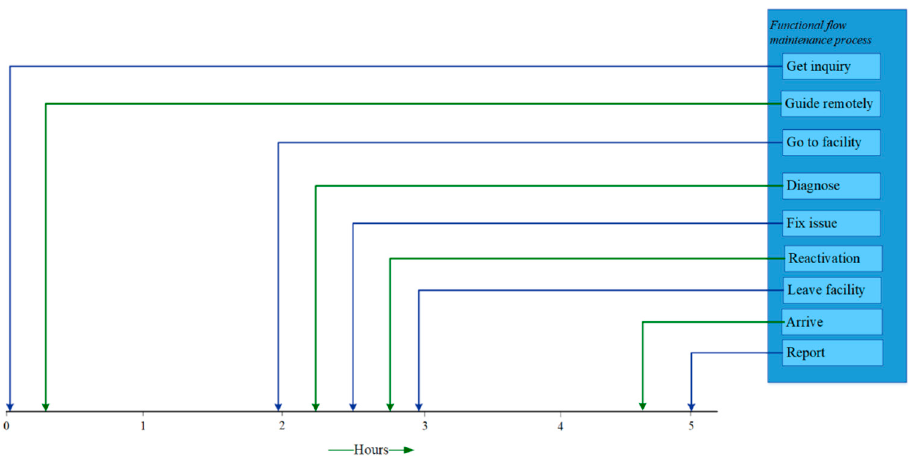
Figure 10. Functional flow model. 2D map: Based on the observations, we developed a 2D map showing the SOI, its context, and its parts. The 2D map can be seen in Figure 11. This conceptual model facilitated the understanding and communication of the SOI context.